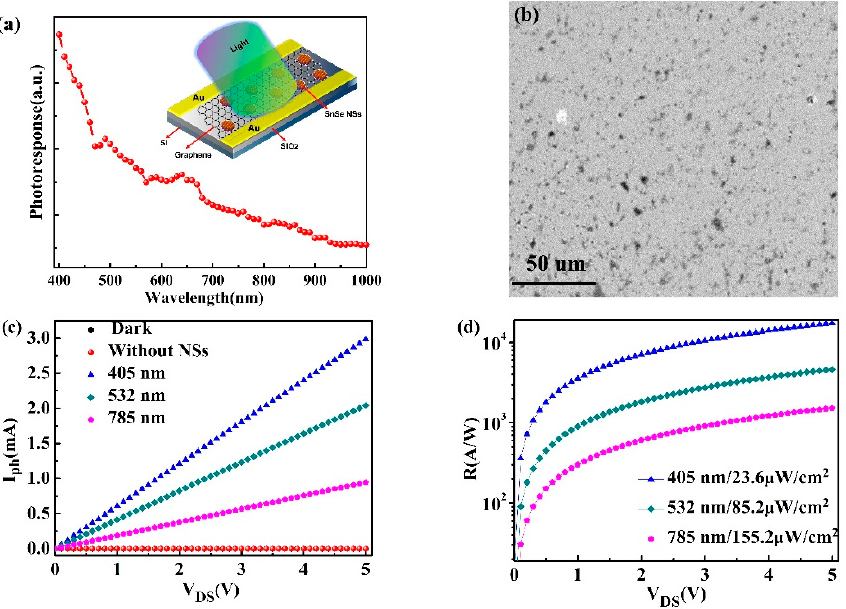
Figure 5. ( a ) Spectral response of the graphene–SnSe NSs photodetector. Inset: schematic diagram of the graphene–SnSe NSs photodetector. ( b ) SEM image of the SnSe NSs on the graphene film. ( c ) Photocurrent of the hybrid device under different light wavelength as a function of V DS (Light power density of 155.2 μ W/cm 2 , V G = 0 V). The photocurrent for the only graphene device shows a negligible effect. ( d ) Responsivities as a function of V DS (V G = 0 V) under different light wavelength, each with the lowest power intensity.